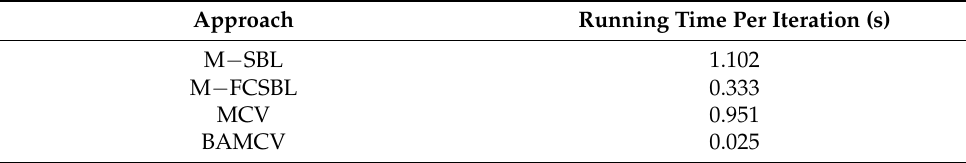
Table 8. Comparison of running time per iteration using MCARM data.